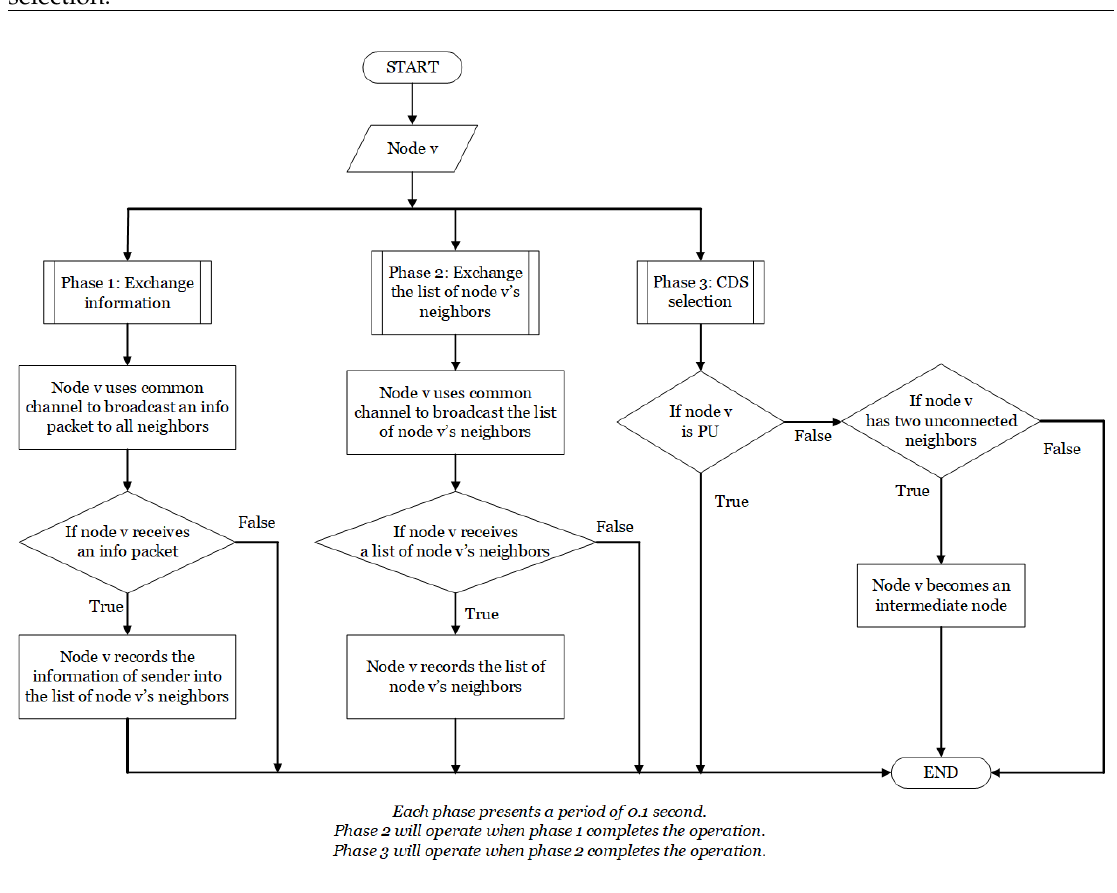
Algorithm 1 The flowchart of proposed connected dominating set (CDS) selection algorithm—CDS